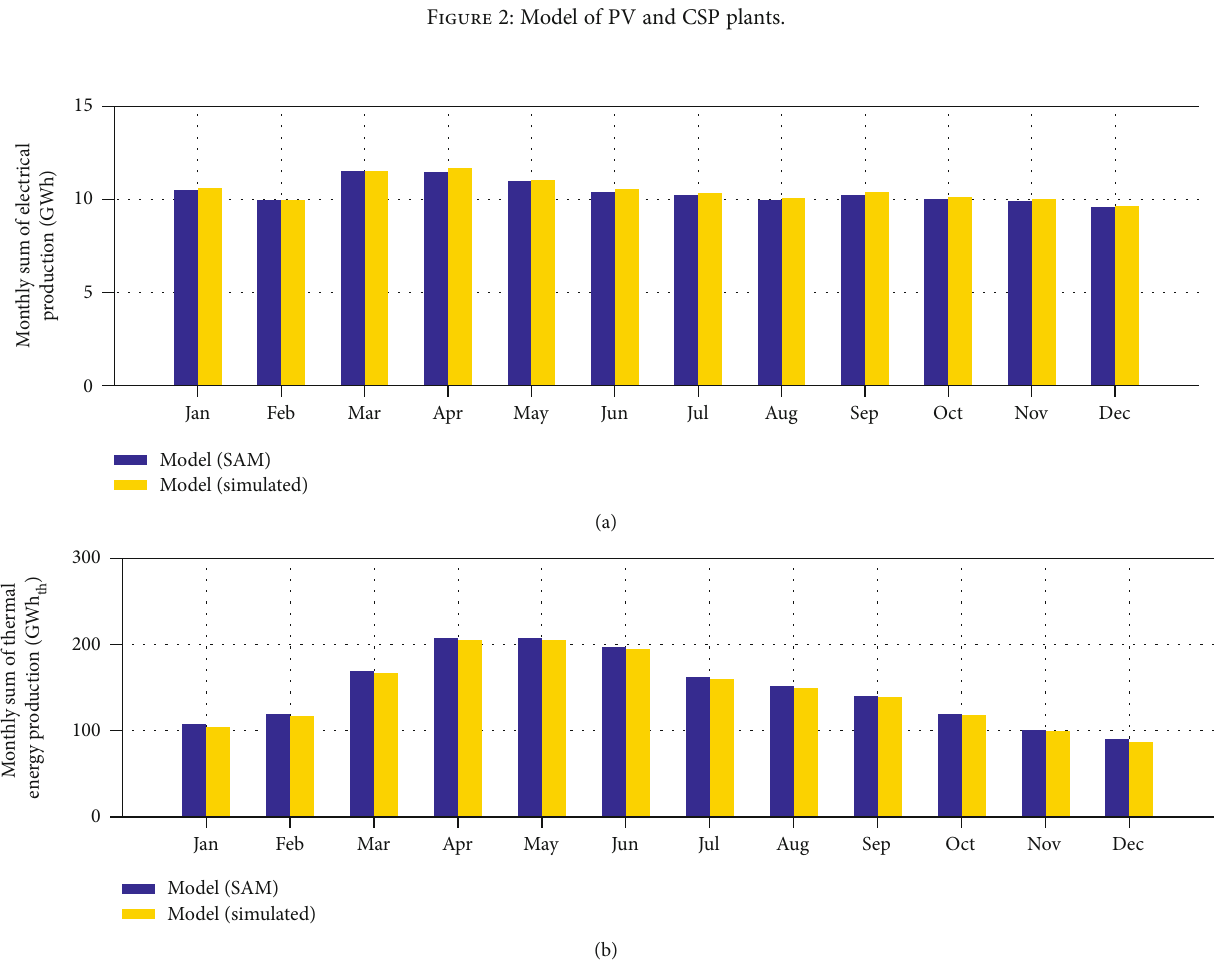
Figure 3: Monthly sum of energy production of the (a) 70MW PV and (b) 160MW